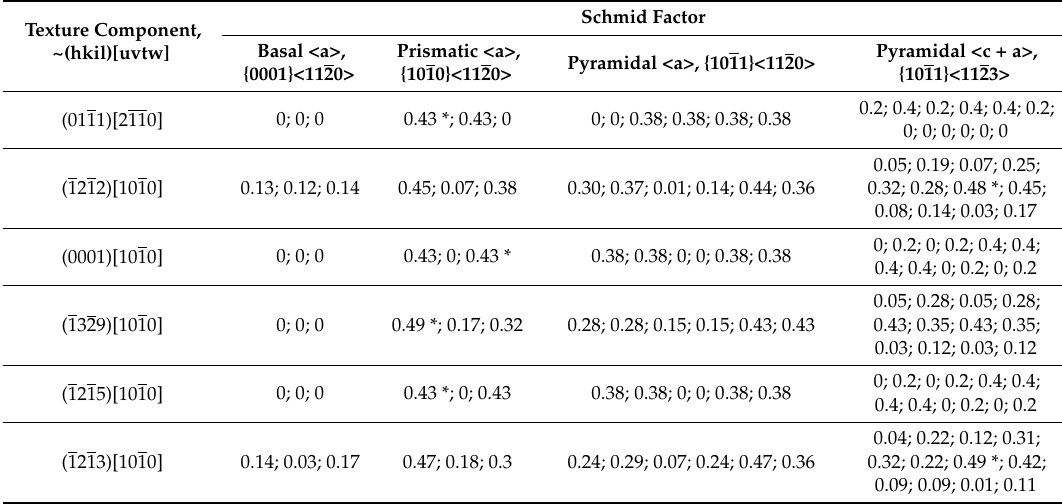
Table 3. Schmid factor values based on obtained major texture components and main slip